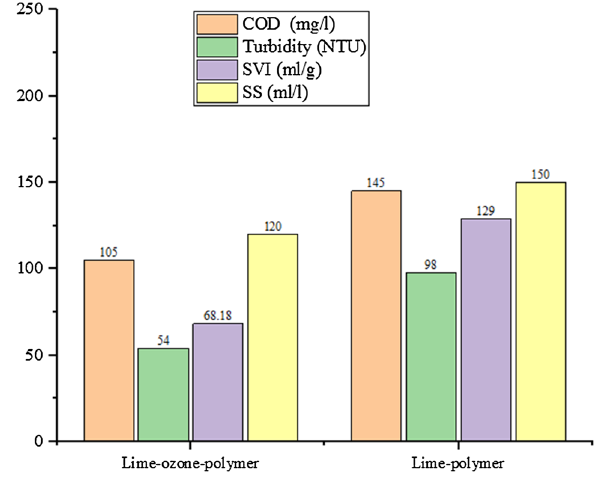
Fig. 6 COD, turbidity, SVI, and SS in the combined process of ozo- nation-coagulation and flocculation and coagulation and flocculation in combination with